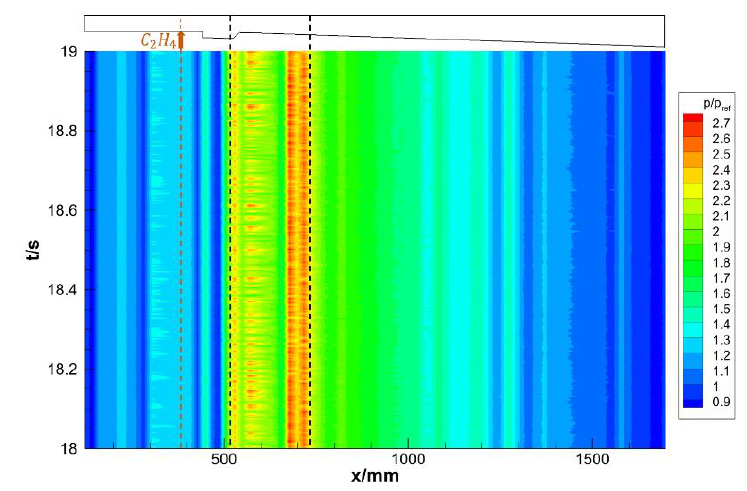
Figure 14. Pressure along x axis at 1.7D 0 I0.144 during 18.0 – 19.0 s.